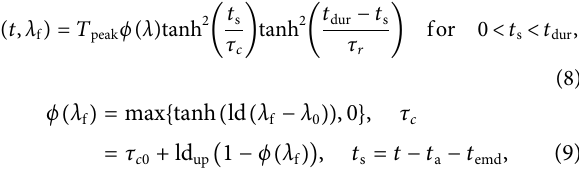
shear strain in fi ber-sheet plane scaling b shear strain in fi ber-normal plane scaling b 3.3 shear strain in sheet-normal plane scaling Active